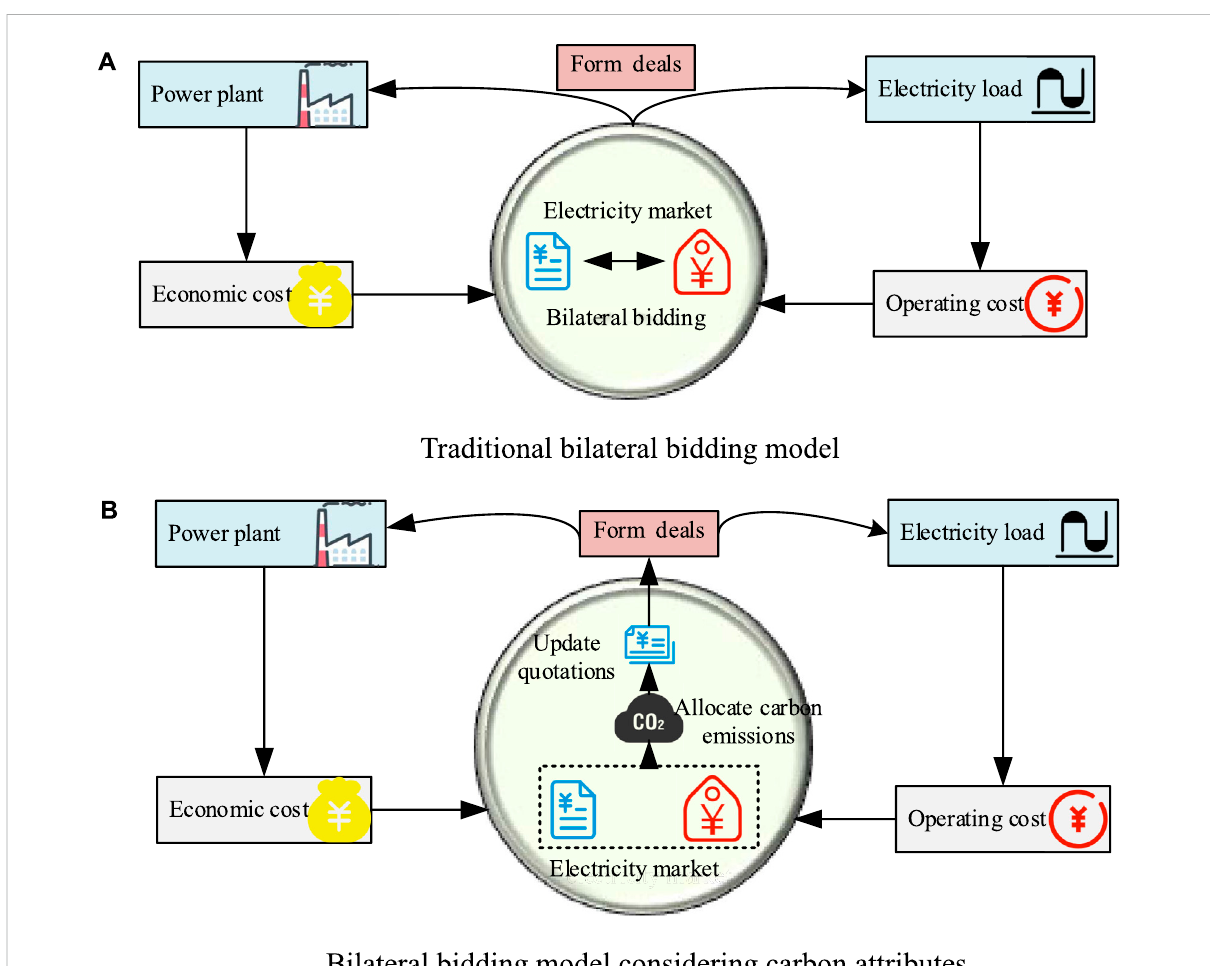
FIGURE 1 Schematic diagram of the change in the bilateral bidding model. (A) Traditional bilateral bidding model. (B) Bilateral bidding model considering carbon